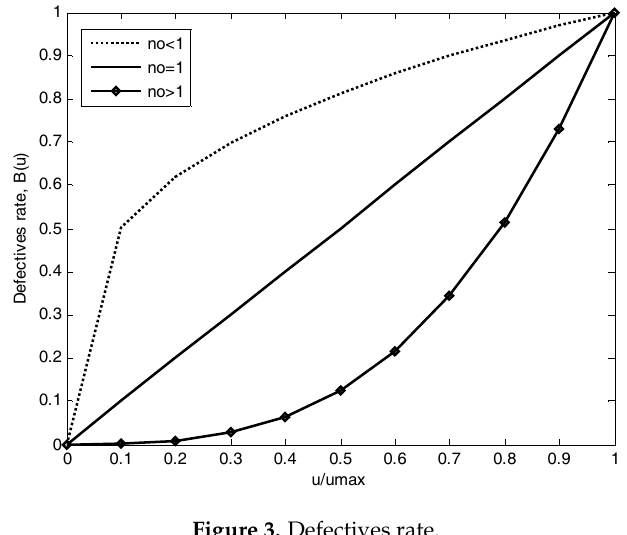
Figure 3. Defectives rate.